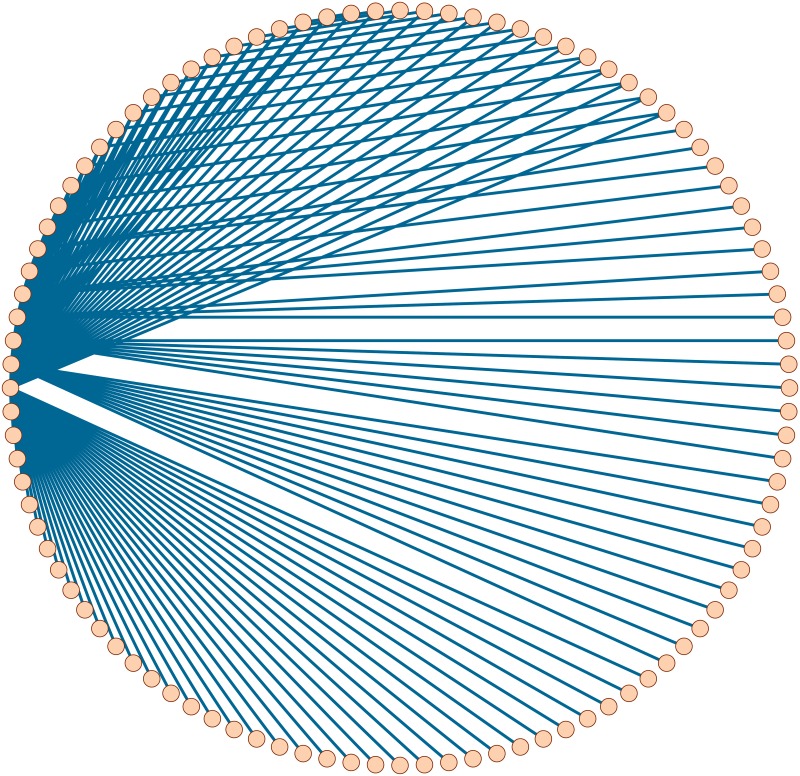
A synthetic scale-free network GSF.